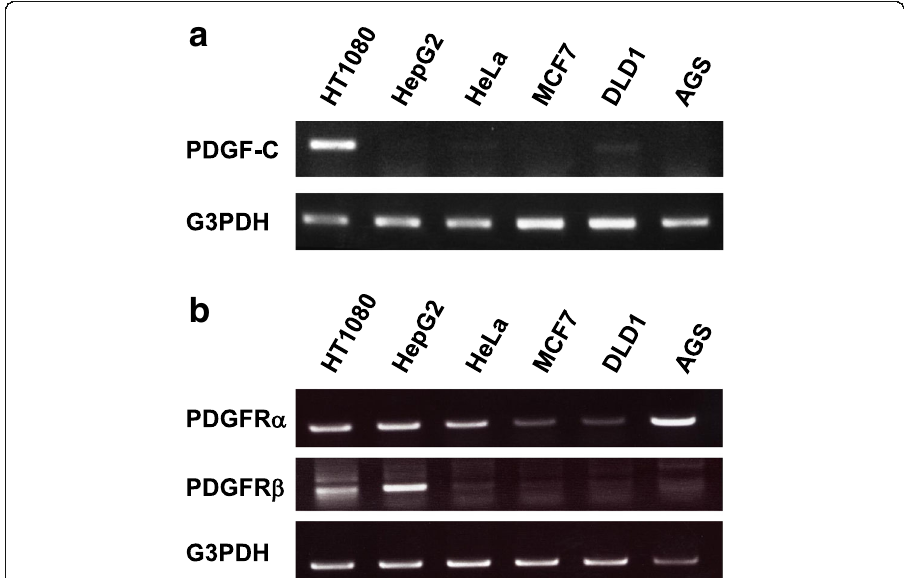
Fig. 1 The expression levels of PDGF-C ( a ) and PDGF receptor ( b ) for six different tumor cell lines: HT1080 (fibrosarcoma), HepG2 (hepatocellular carcinoma), HeLa (cervical carcinoma), MCF7 (breast carcinoma), DLD1 (colon carcinoma), and AGS (stomach carcinoma). In each case, total RNA was prepared and subjected to RT-PCR. Glycerol-3-phosphate dehydrogenase (G3PDH) was used as a loading control, and the results are representative of three independent